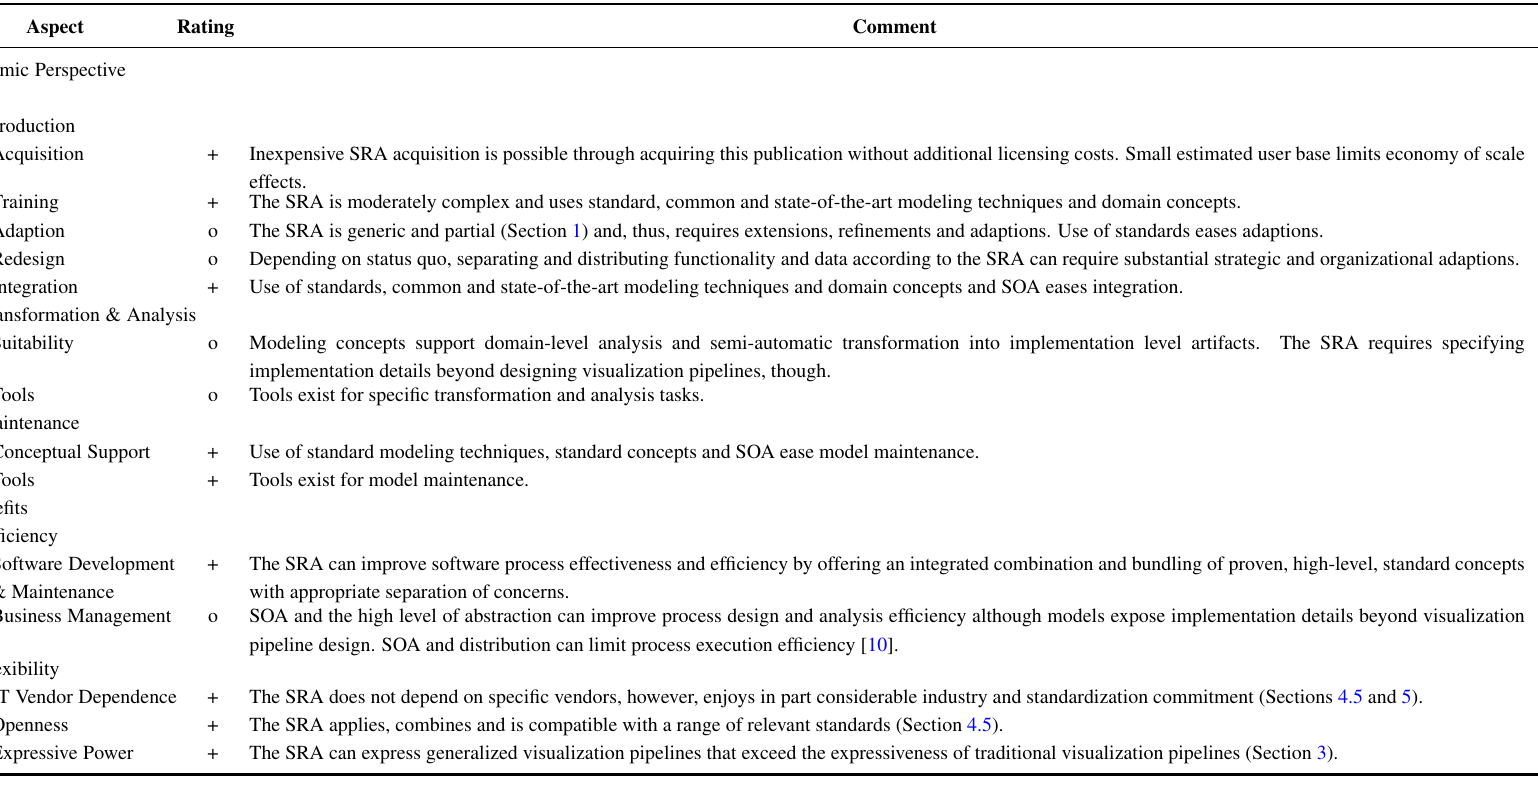
Table 6. Assessment of the proposed SRA for 3DGeoVSs based on SSI structured into four perspectives each defining a set of evaluation criteria as proposed by Frank